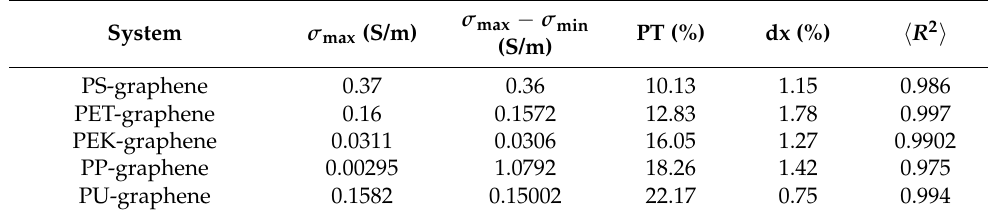
Table 4. Parameters used in the fitting of the conductivity values, obtained with Equation (3).